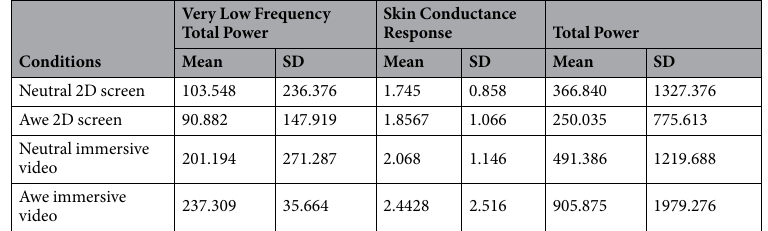
Table 2. Descriptive Statistics of Very Low Frequency Total Power and Skin Conductance Response (Sympathetic indexes) and Total Power (Parasympathetic index). Note . n =